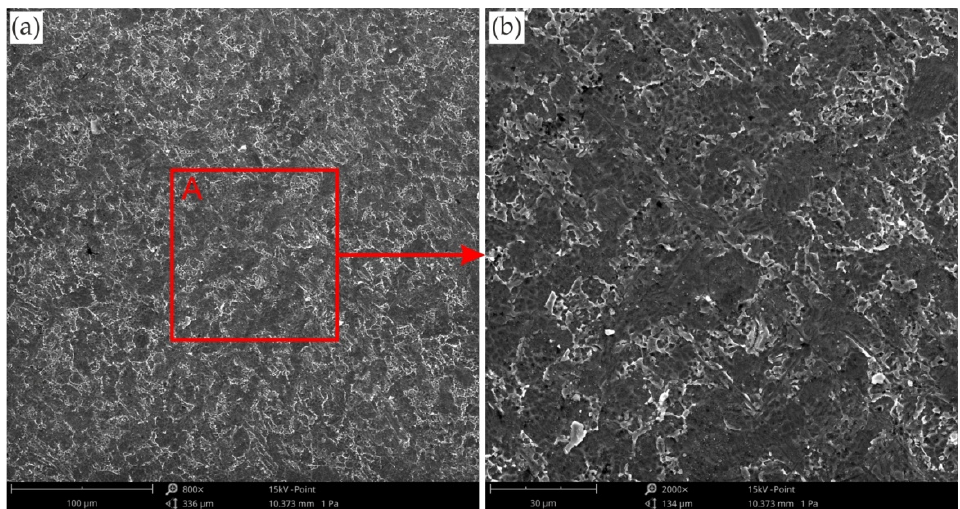
Figure 10. ( a ) SEM micrograph of the outer surface of the drawpiece formed with a p = 0.1 mm, f = 2000 mm/min and n = 600 rpm, ( b ) magnification of the A area.